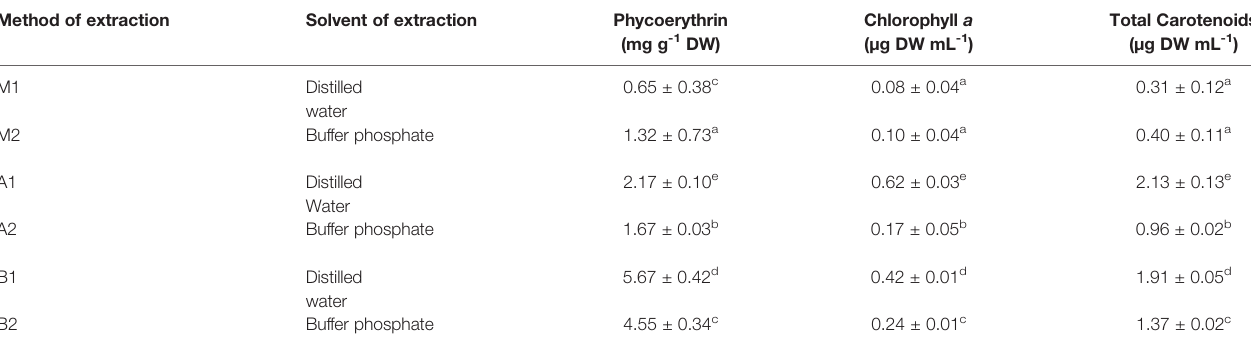
TABLE 4 | Pigmentary composition (Phycoerythrin content, Chlorophyll a and Total of carotenoids of the aqueous extract of S. skottsbergii at selected conditions for ultrasound (US) and high-pressure homogenization (HPH). Method of